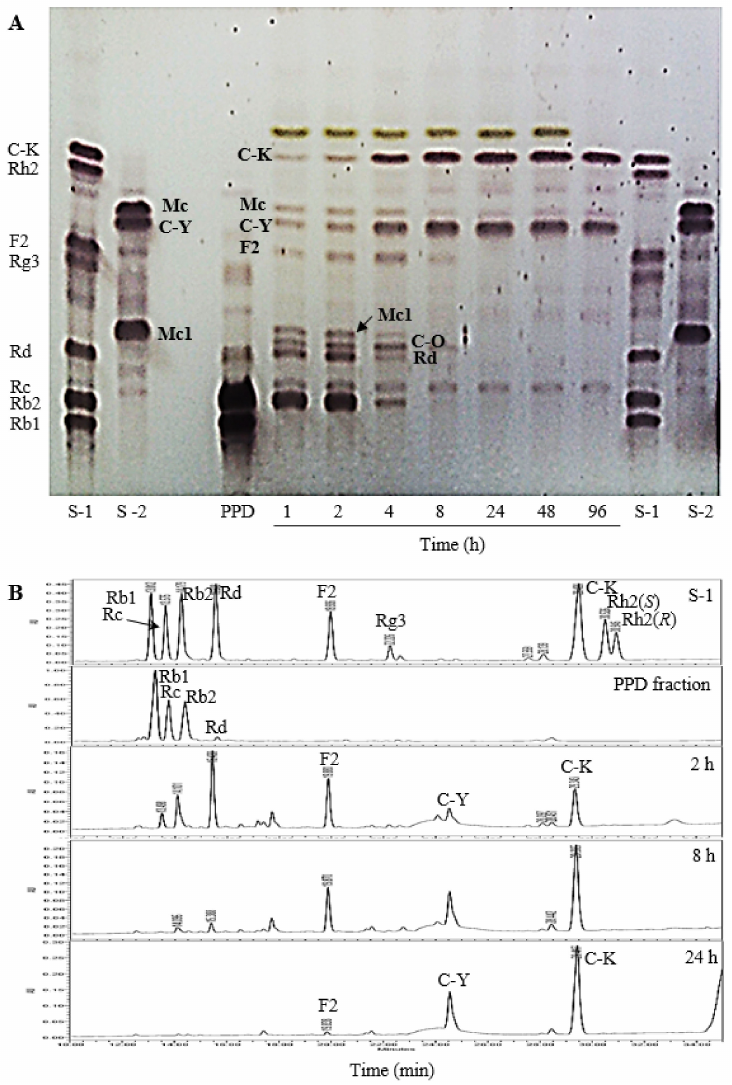
Figure 3. Time course of biotransformation of PPDG-F by FFEP. ( A ) TLC; ( B ) HPLC